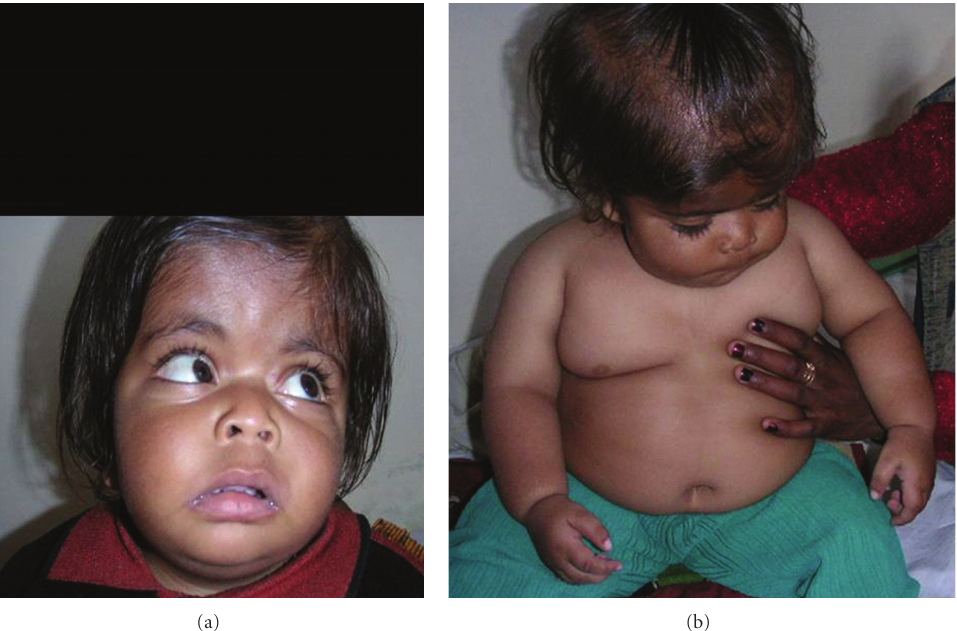
Figure 1: Clinical photograph showing facial dysmorphism and generalized obesity.